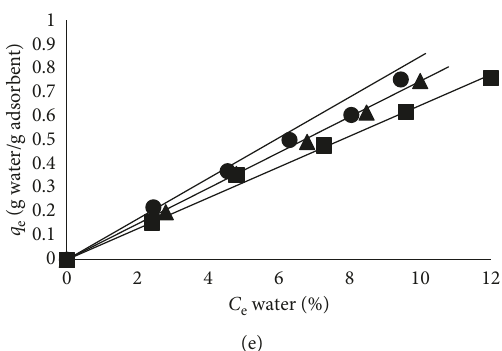
Figure 4: Adsorption isotherms of water at same adsorbents in various temperatures. (a) PVA/Zeo/AC 1 :1:1; (b) PVA/Zeo/AC 1 :1: 0.75; (c) PVA/Zeo/AC 1:1: 0.5; (d) PVA/Zeo/AC 1:1:0.25; (e) PVA/Zeo/AC 1:1:0. , q